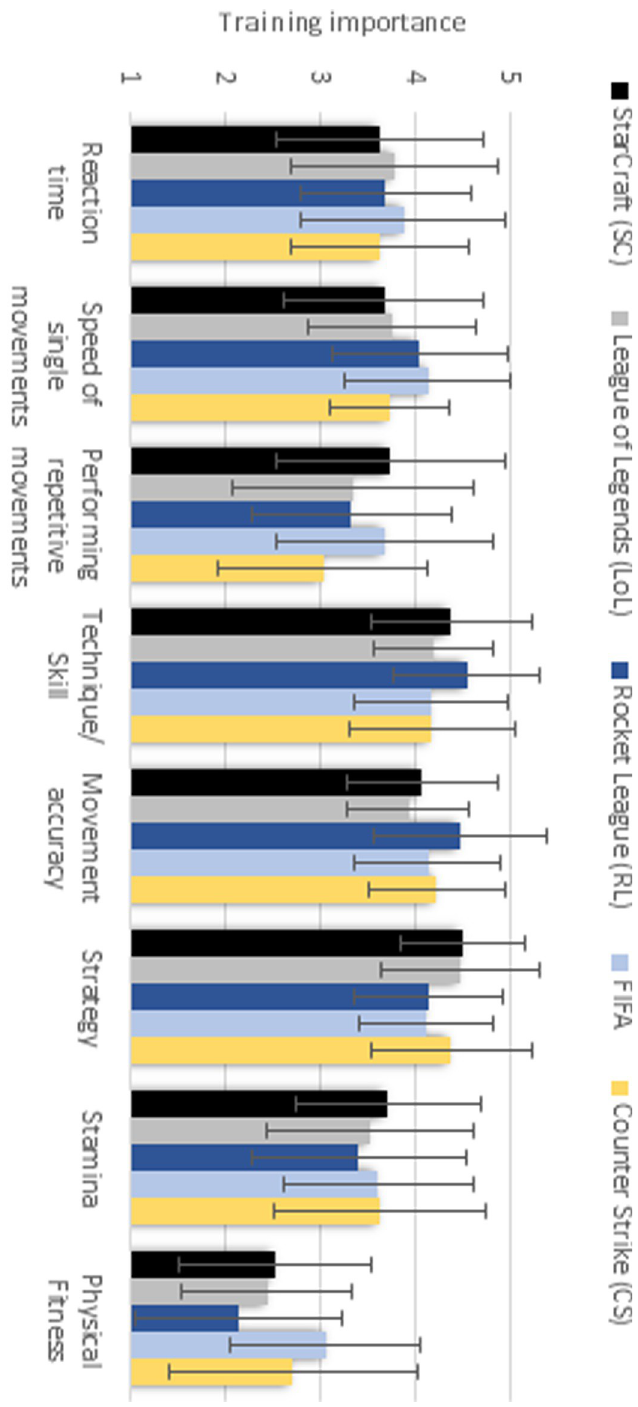
Fig 13. Importance of training fields. Scale: 1 –not important at all; 3 –somewhat important; 5 –very important.